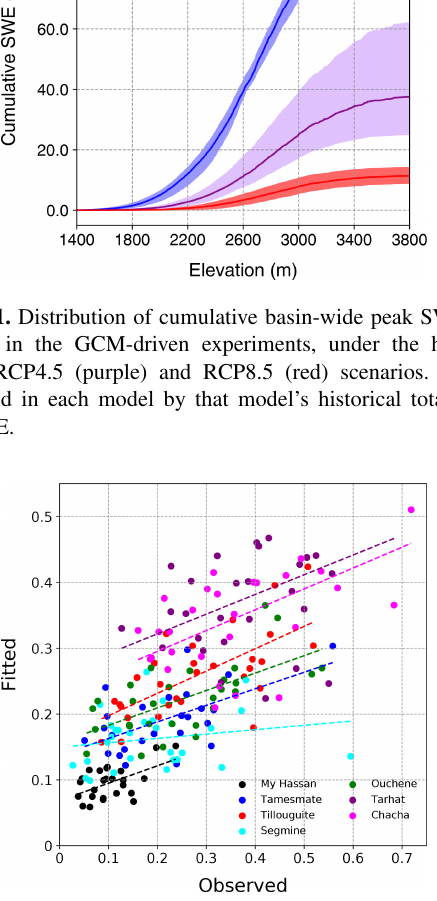
Figure 12. Fitted runoff coefficient values against observed values (defined with TRMM precipitation), for the seven catchments in our study area. Best-fit linear regression lines are shown by dashed lines.